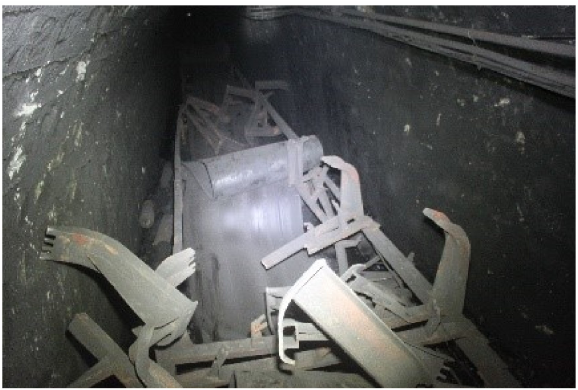
Figure 2. A photo of the steel cord conveyor belt after a fracture